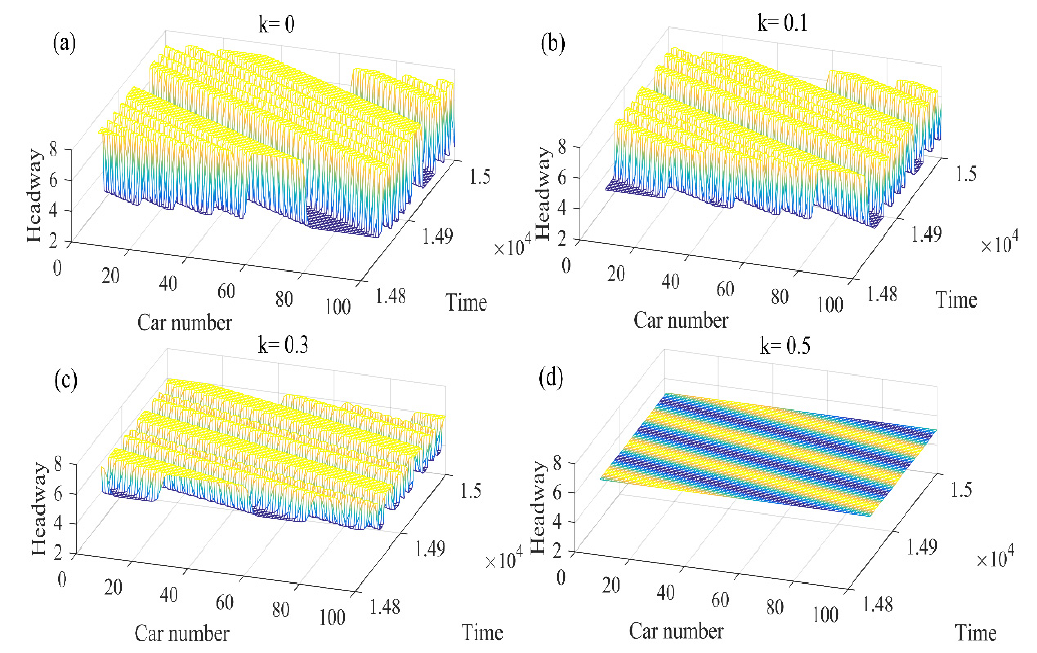
k . Figure 6. Spatiotemporal evolution patterns of the headway from t = 14,800 to 15,000 with different values of k